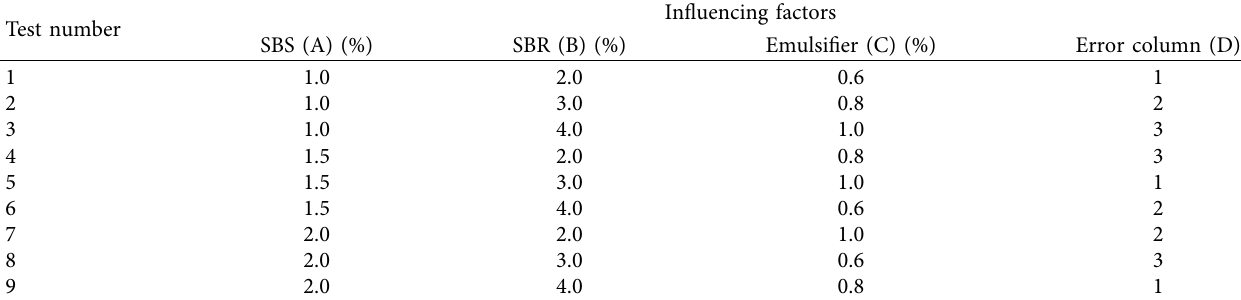
Table 7: Te factors and levels of diferent experimental groups in the orthogonal test.